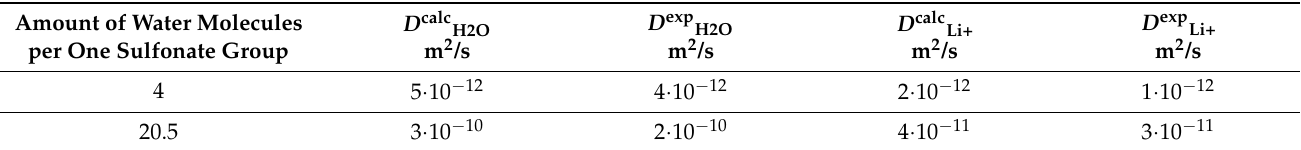
Table 1. Calculated from 1 H and 7 Li relaxation data ( D calc ) and experimentally measured ( D exp ) water molecule and lithium cation self-diffusion coefficients. Amount of Water Molecules per One Sulfonate